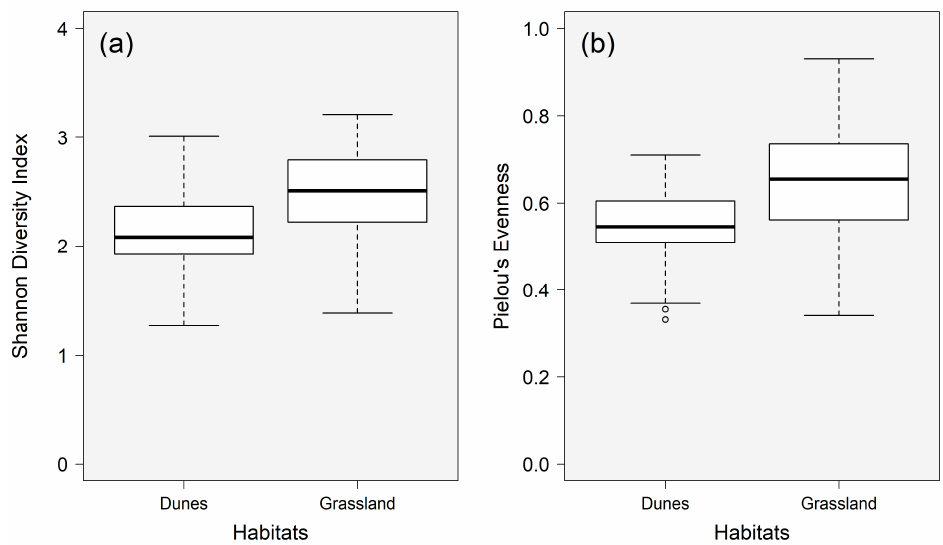
Figure 2. ( a ) Shannon diversity index and ( b ) Pielou’s evenness of cercozoan and endomyxan communities in biocrusts from coastal dunes (Germany) and subarctic grassland (Iceland) (significant differences between habitats, p = 0.03 and p = 0.02 for Shannon index and evenness, respectively). Individual points outside quartiles are plotted as outliers of the data.